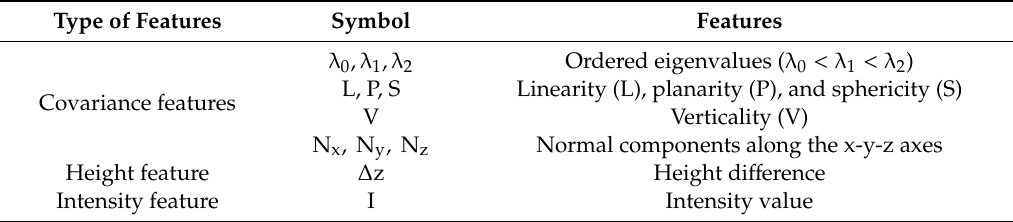
Table 2. List of various features used in the proposed